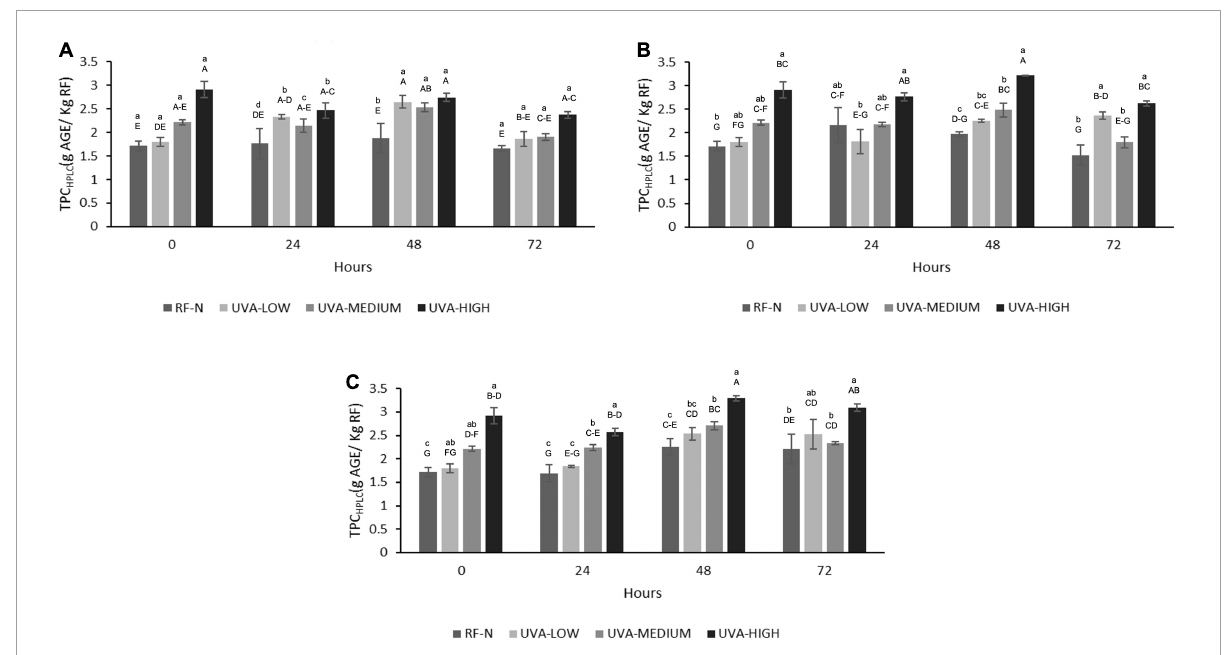
FIGURE4 Total phenolic content determined by HPLC (TPC HPLC ) of UVA-treated strawberry by-products during storage at (A) 5 ◦ C, (B) 10 ◦ C, (C) 15 ◦ C. RF-N: Strawberry agro-industrial by-product control. UVA-LOW: RF irradiated with 28.8 KJ/m 2 . UVA-MEDIUM: RF irradiated with 57.6 KJ/m 2 . UVA-HIGH: RF irradiated with 86.4 KJ/m 2 . Different lower-case letters, mean significant differences ( p ≤ 0.05) among different treatments at the same storage time. Different capital letters mean significant differences ( p ≤ 0.05) among different storage times.